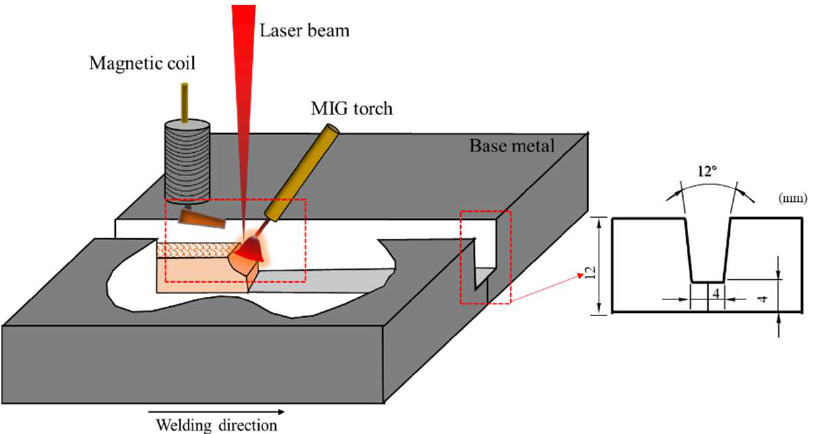
Figure 2. Schematic diagram of the experimental process and groove size.